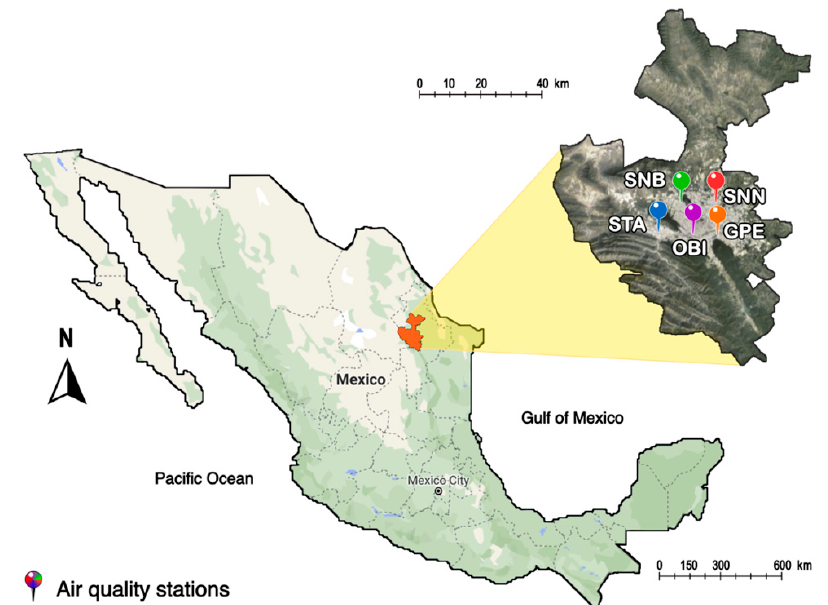
Figure 1. Monterrey Metropolitan Area and the selected monitoring sites for the development of the forecasting model.